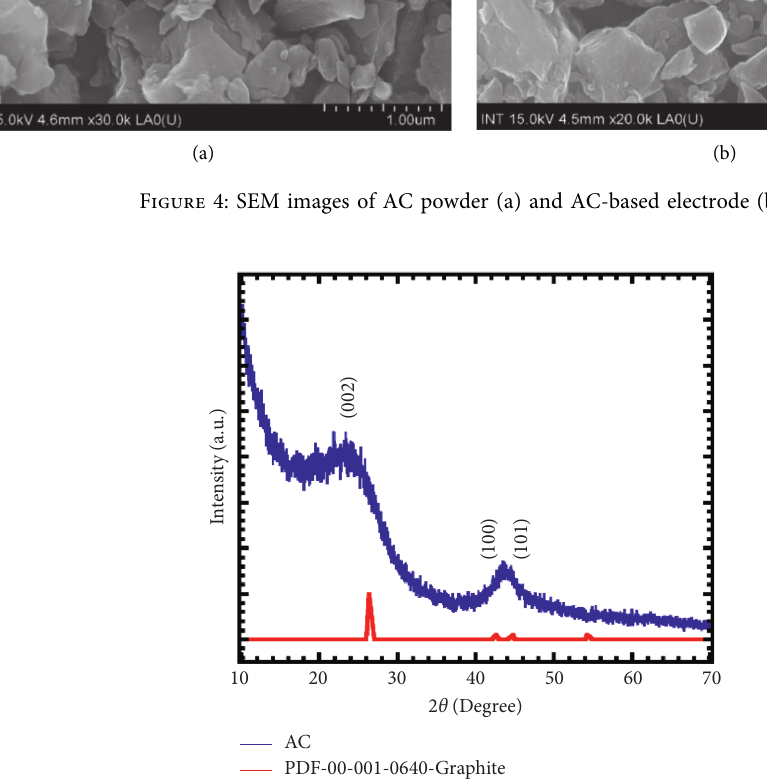
Figure 5: Powder XRD pattern of